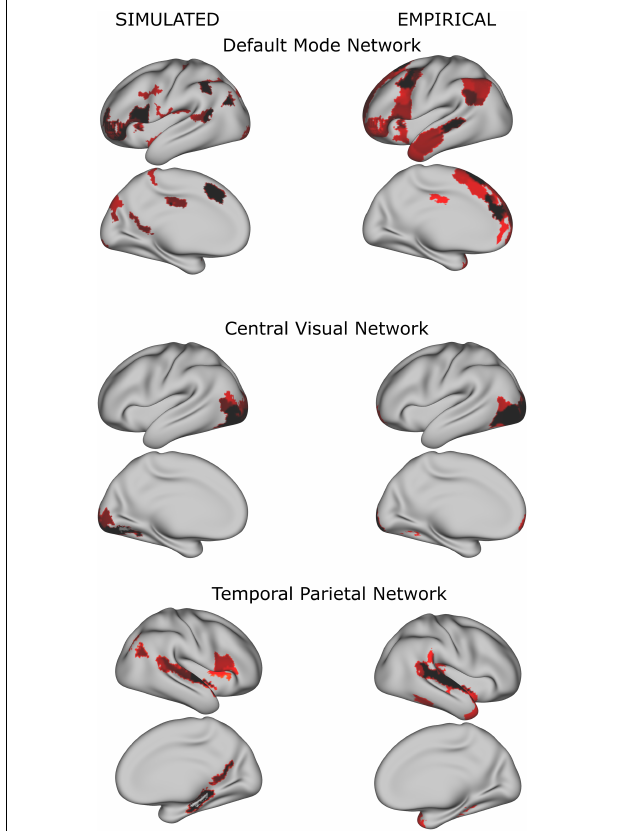
FIGURE 3 | Examples of group whole-brain functional networks rendered on the standard brain. The left column has been retrieved from the simulated time series (using a TR = 720 ms), the right column from the empirical time series. Some of these networks have a high overlap with classical resting state networks (Yeo et al., 2011) such as the Default Mode Network, Central Visual Network and Temporal Parietal